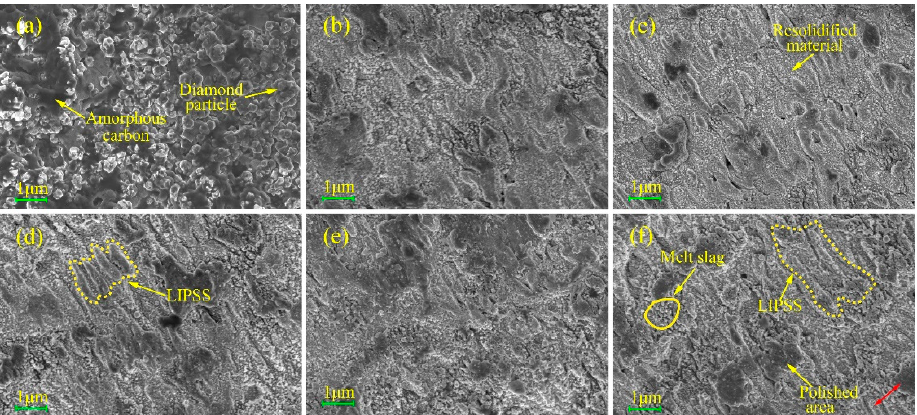
Figure 2. SEM photographs of fs laser-irradiated regions under different scanning speeds. ( a ) As-grown; ( b ) 2.0 mm/s; ( c ) 1.8 mm/s; ( d ) 1.6 mm/s; ( e ) 1.4 mm/s; and ( f ) 1.2 mm/s. The red arrow indicates the direction of laser polarization.